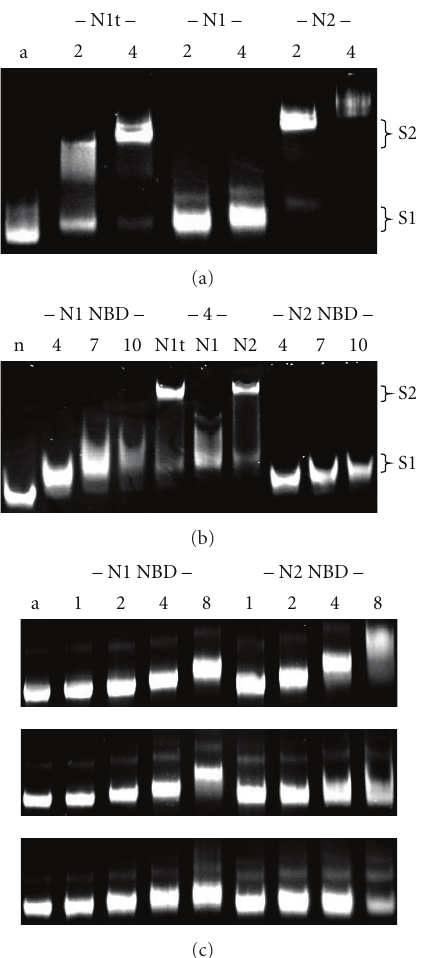
Figure 2: HMGN association with nucleosomal array is capable of inducing the S2 transition. Gel labels indicate HMGN identity, (N1t, HMGN1t; N1, HMGN1; N2, HMGN2; a, 12-array alone) and numbers designate HMGN :nucleosome molar stoichiometry. (a) HMGN binding to 12-array at low (top) and near physiological ionic strength (bottom). ((b), (c)) HMGN binding to 12-array at near physiological ionic strength with 1mM Mg 2+ .